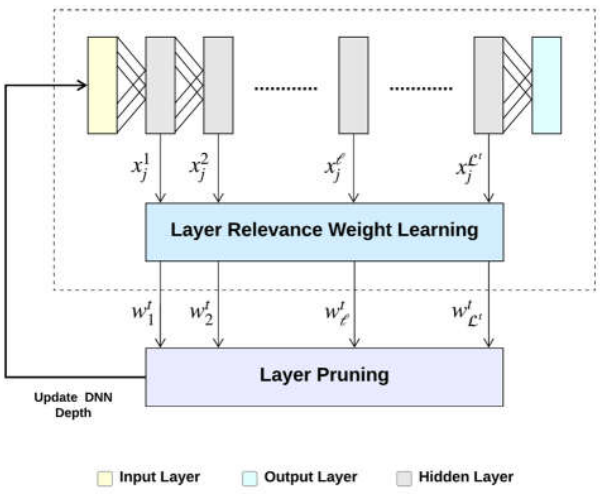
Figure 1. The block diagram of the proposed system.